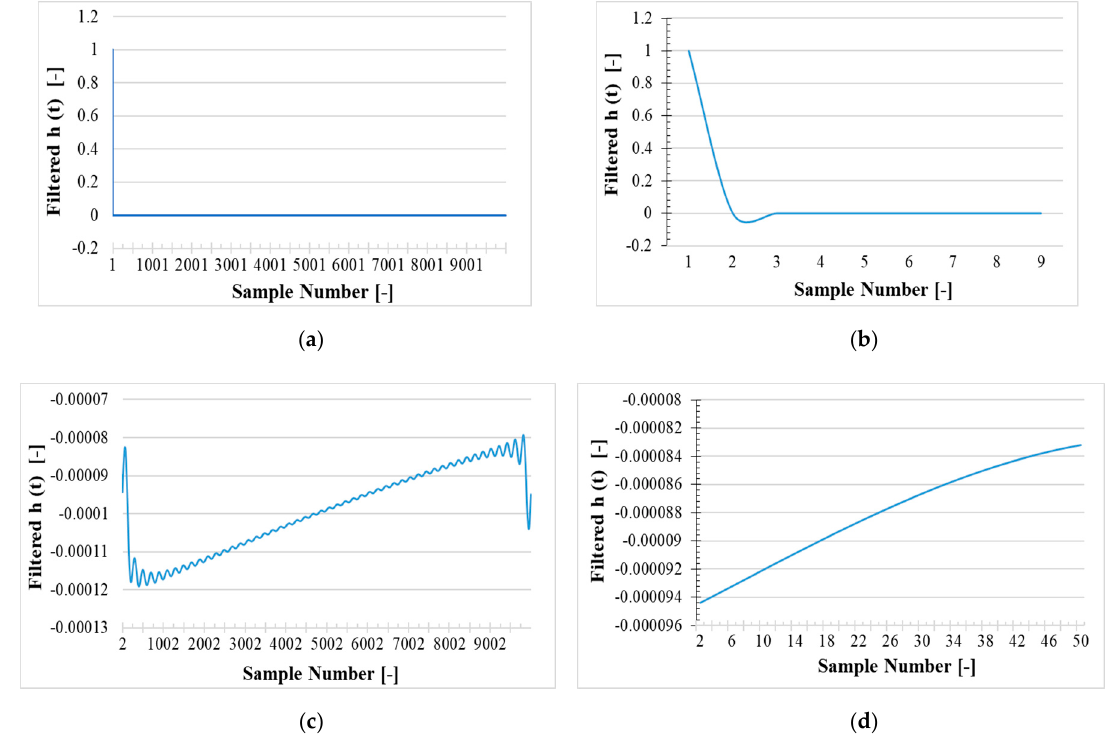
Figure 8. Time domain filtered version of the LPVT sampled data transfer function. ( a ) all 10,000